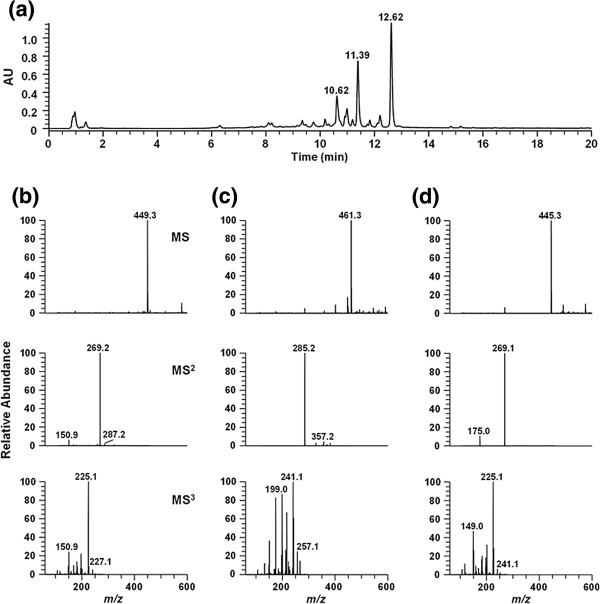
Results of UPLC-MS analysis of the 3 main compounds of A. pilosa aqueous extract. (a) Chromatogram at 350 nm, (b) mass spectrum of apigenin-hexose ([M-H]-, m/z 449.3) at an RT of 10.62 min, (c) luteolin-glucuronide ([M-H]-, m/z 461.3) at an RT of 11.39 min, and (d) apigenin-glucuronide ([M-H]-, m/z 445.3) at an RT of 12.62 min.